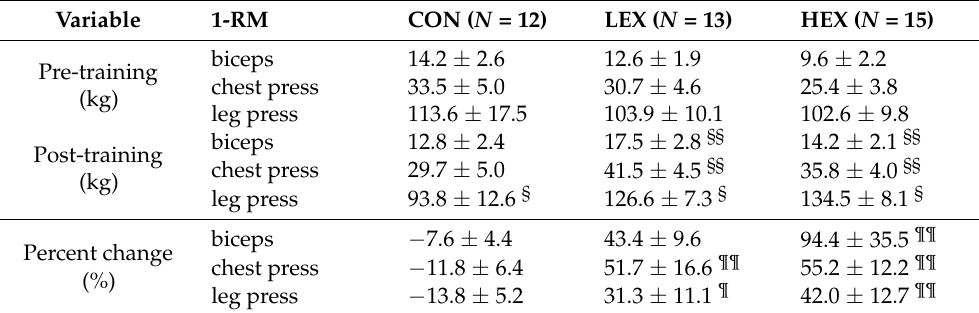
Table 2. Changes in muscular strength for the CON, LEX, and HEX groups following 24 weeks of resistance training or a control period.